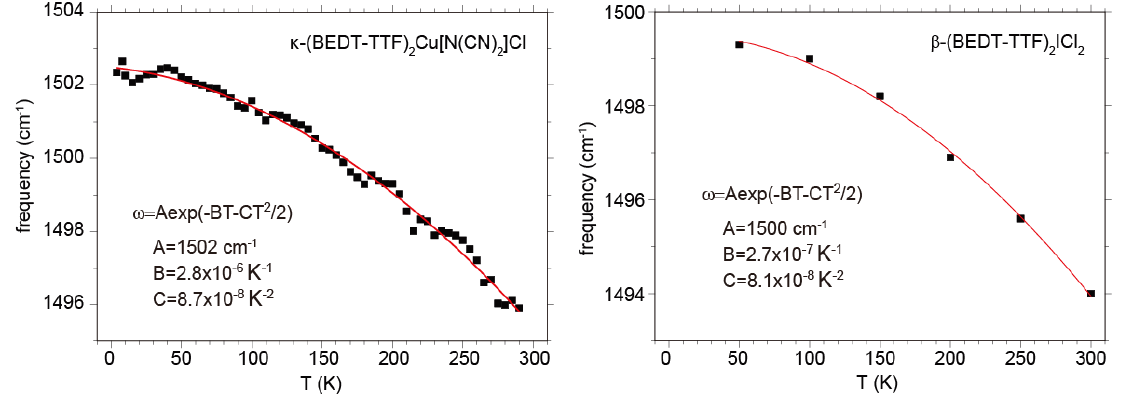
ICl . The red line is the best fit equation, ω = A exp( − BT − CT 2 /2), 2 2 , B = γβ , and C = γβ . 0 0 1